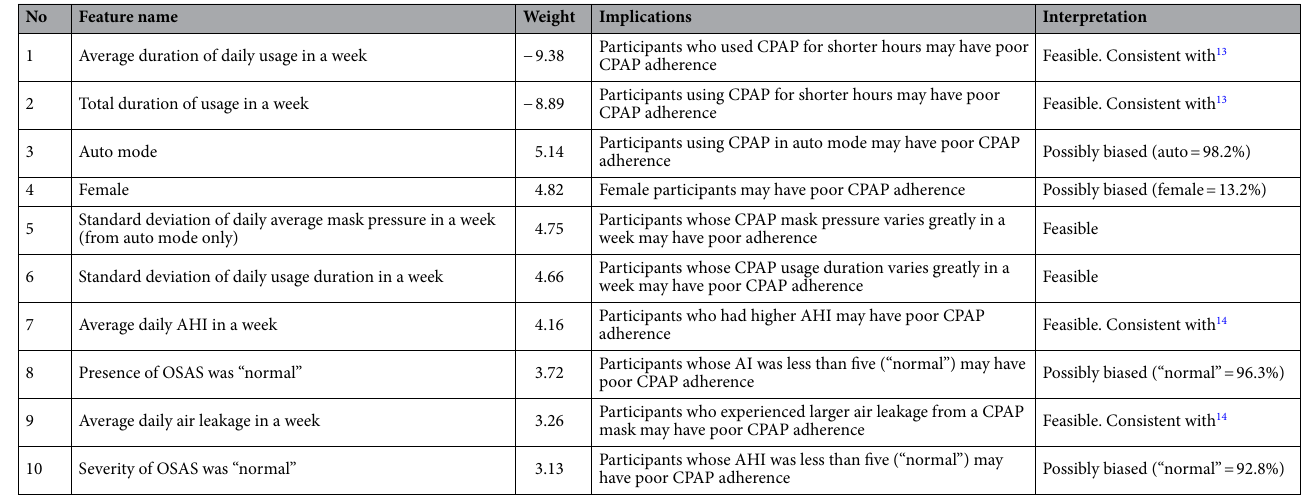
Table 3. List of top ten factors possibly correlated to poor CPAP adherence obtained with highest ranking accuracy. CPAP continuous positive airway pressure; AHI apnea–hypopnea index; AI apnea index; OSAS obstructive sleep apnea